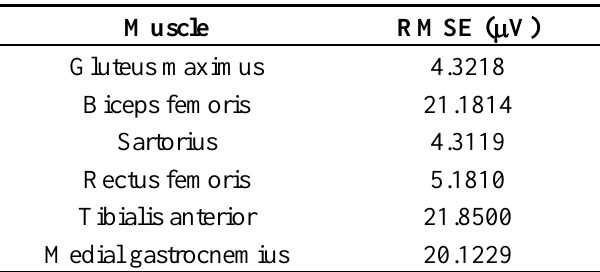
Table 3. RMSE errors between envelopes obtained from our measured EMG signals and envelopes provided by Winter